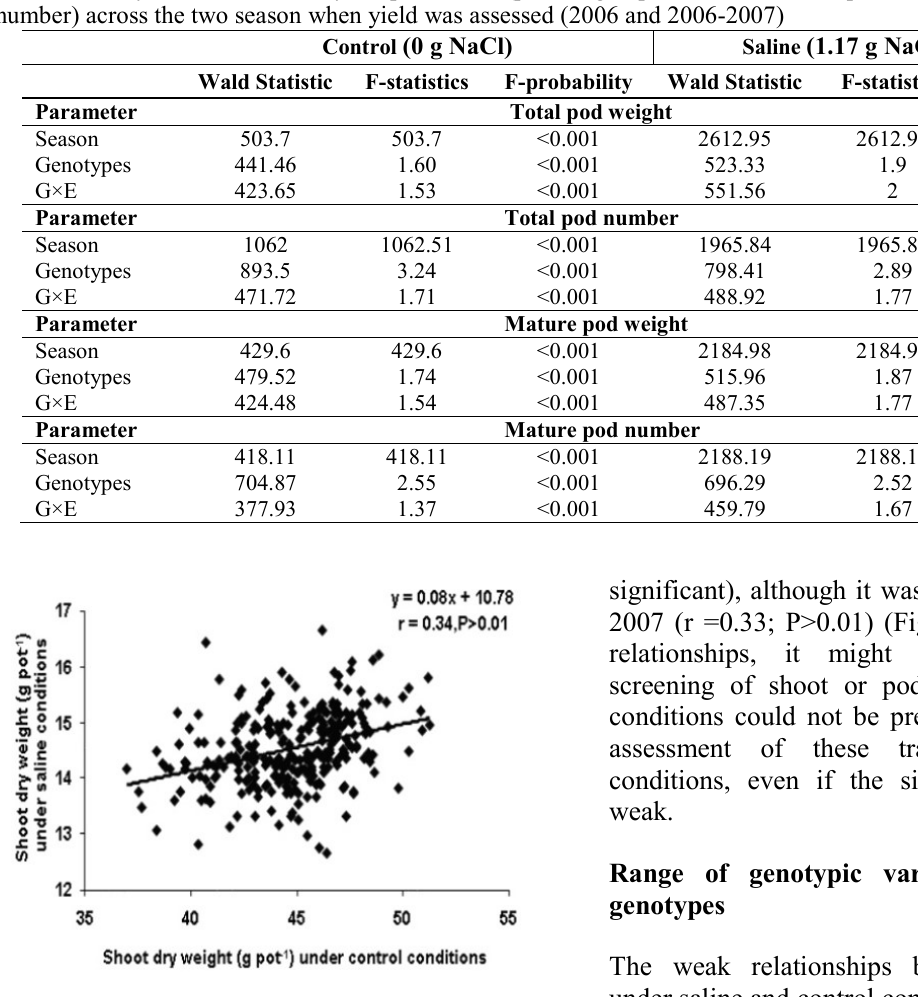
Fig. 2. The short biomass diagram. Relationship of shoot biomass under saline and control conditions in 2005. Data are the mean (n=3) of 275